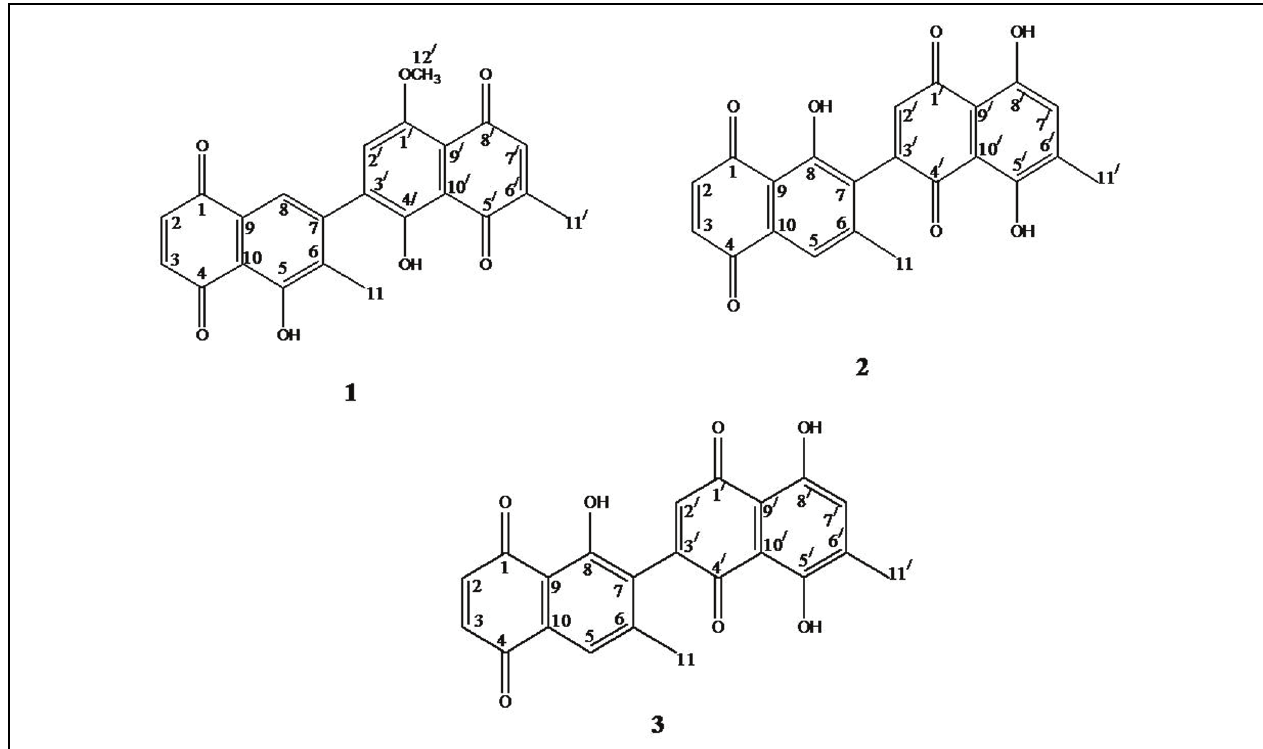
FIGURE 1 | Structures of compounds